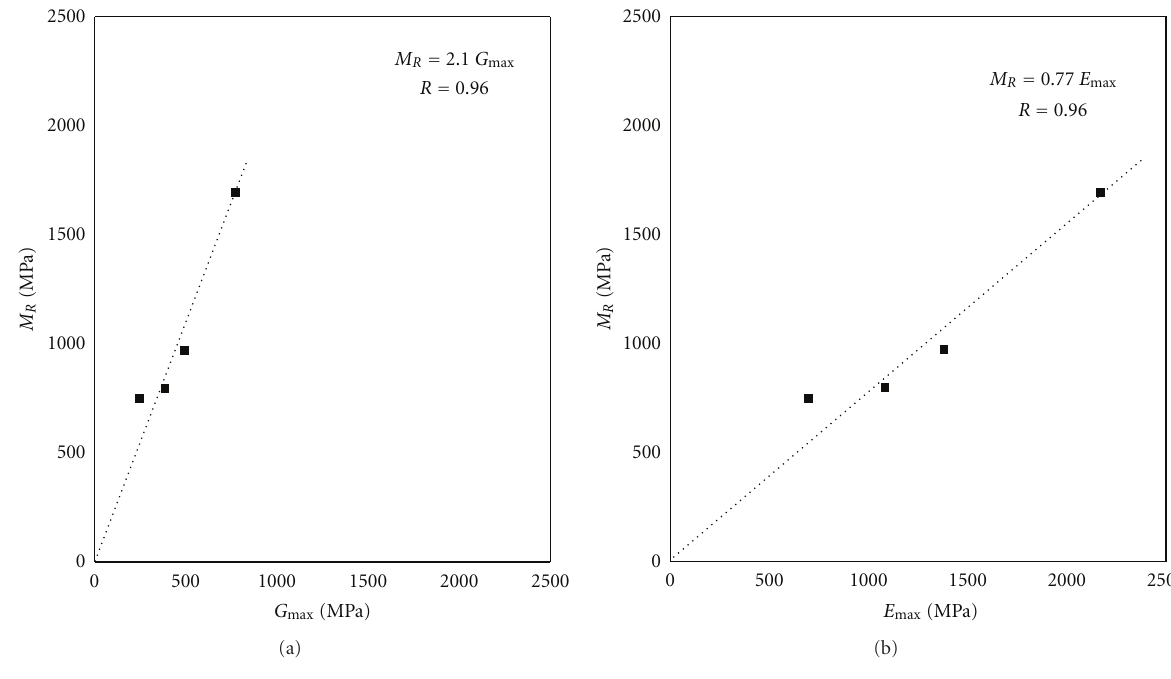
Figure 7: A comparison between M R with G max and E max